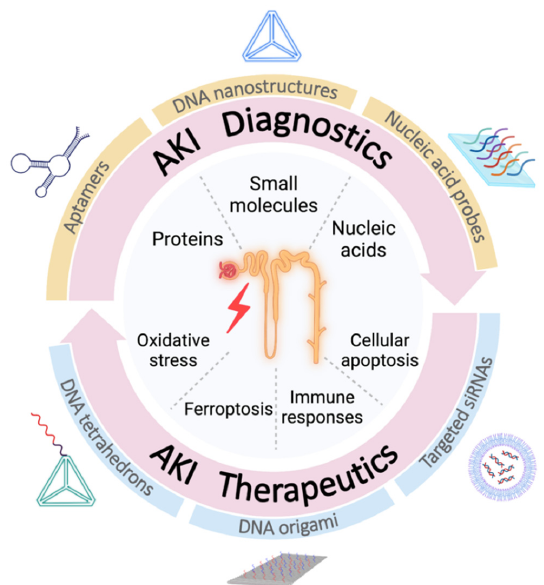
Figure 1. Schematic diagram of how nucleic acid nanotechnology plays a part in the diagnostic and therapeutic strategies of acute kidney injury (AKI). In AKI diagnostics, aptamers, DNA nanostructures as well as nucleic acid probes can be functionalized to detect AKI-related protein biomarkers, small molecules and nucleic acids. Meanwhile, in AKI therapeutics, oxidative stress, ferroptosis, immune responses and cellular apoptosis can be targeted with DNA tetrahedrons, DNA origamis and well-directed short interference RNAs (siRNAs). Created with BioRender.com (26 February 2022).